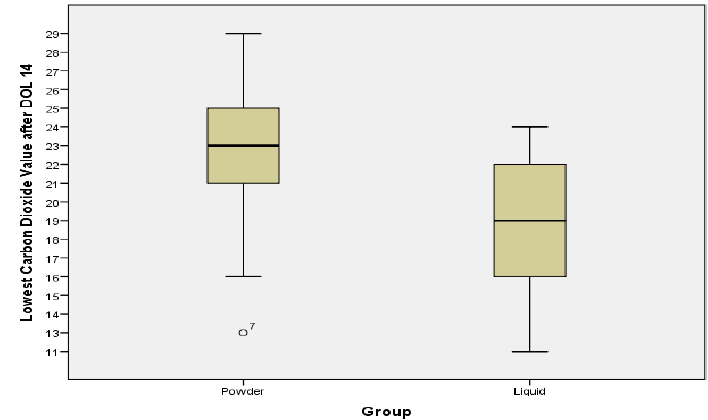
Figure 2. CO2 levels between groups after Day of Life 30. The lowest CO2 levels